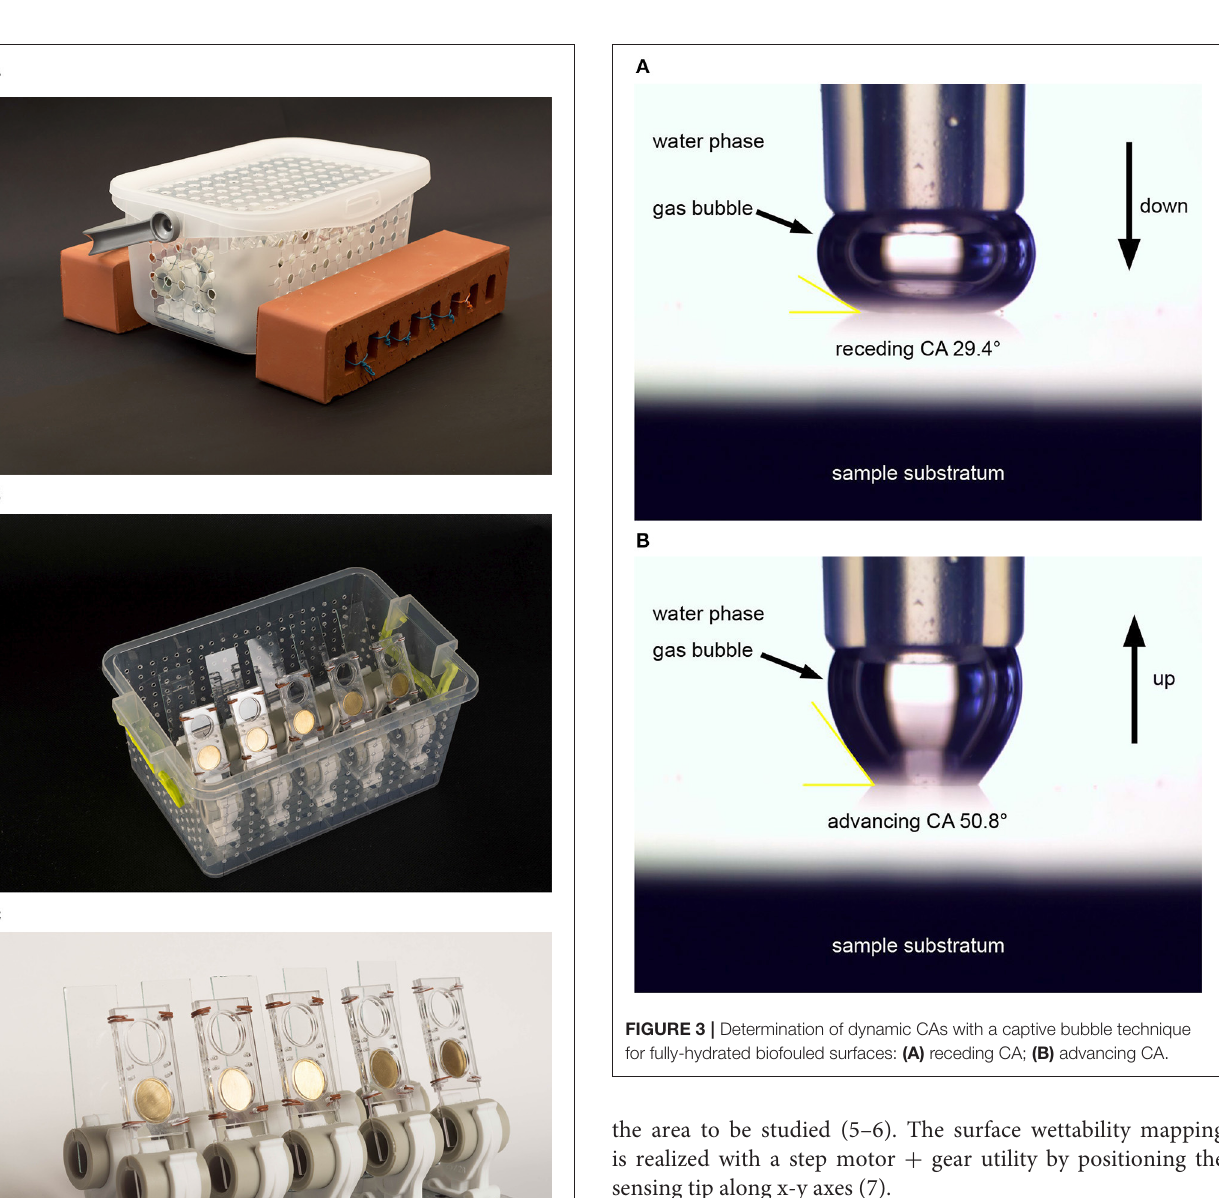
the area to be studied (5–6). The surface wettability mapping is realized with a step motor + gear utility by positioning the sensing tip along x-y axes